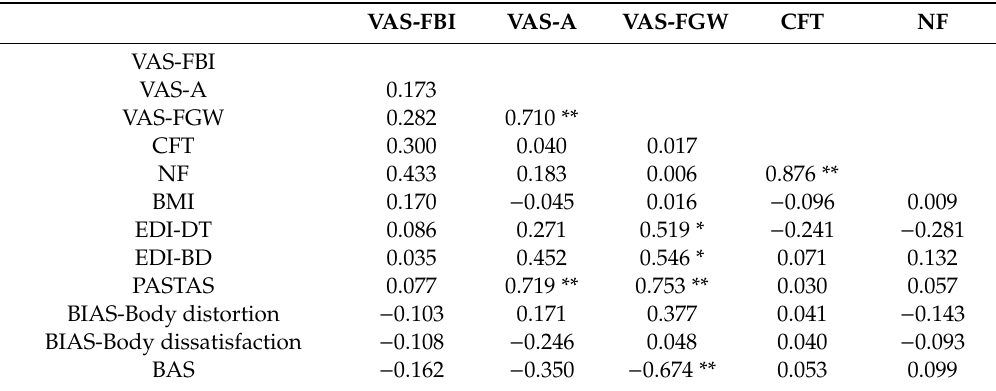
Table 5. Correlations between ED measures and VR body exposure responses in healthy participants with high